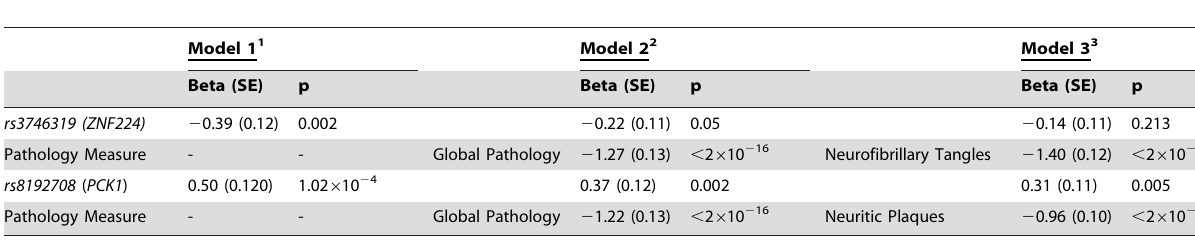
Table 7. Distinct pathways of ZNF224 and PCK1 association with